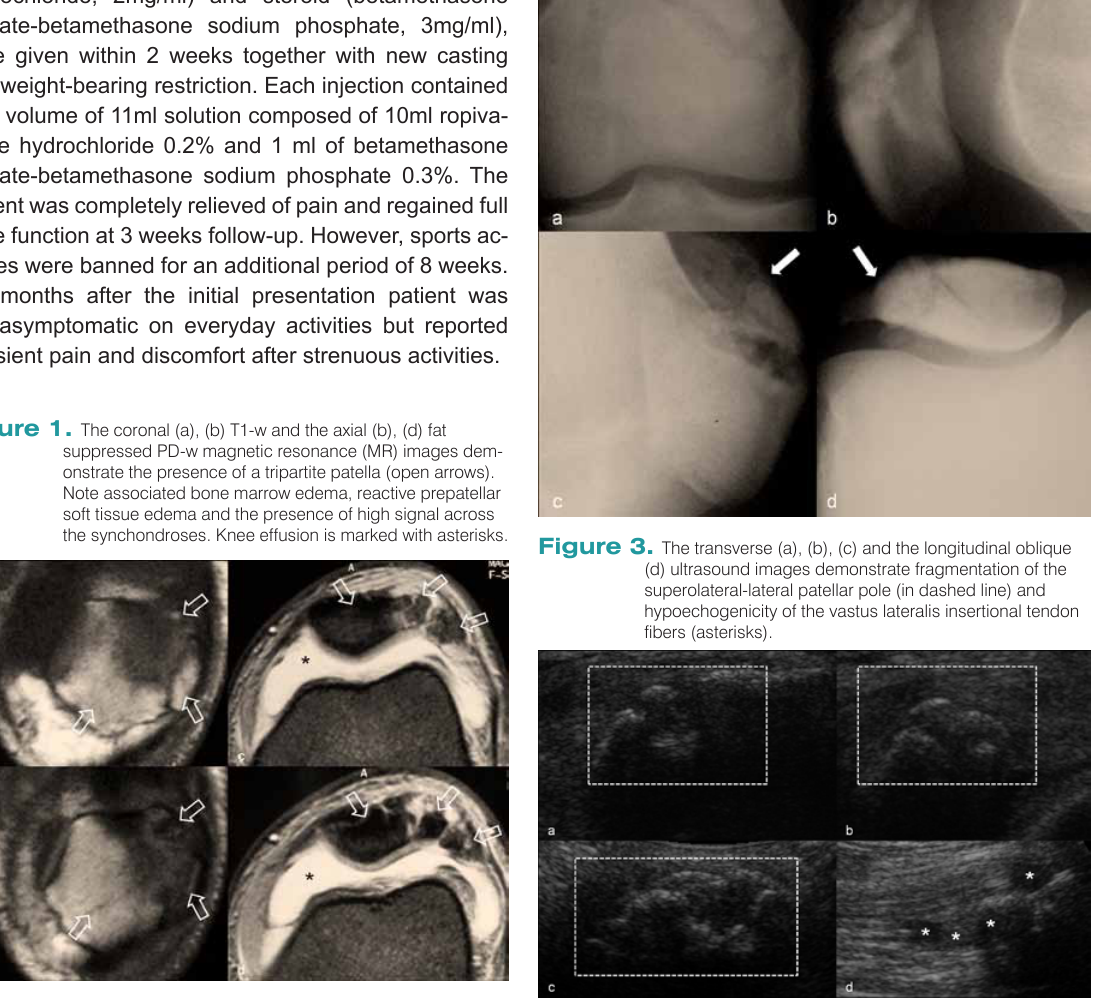
Figure 2. The anteroposterior (a), lateral (b), lateral-oblique (c) and tangential view (d) radiographs show fragmentation of the superolateral-lateral patellar pole.